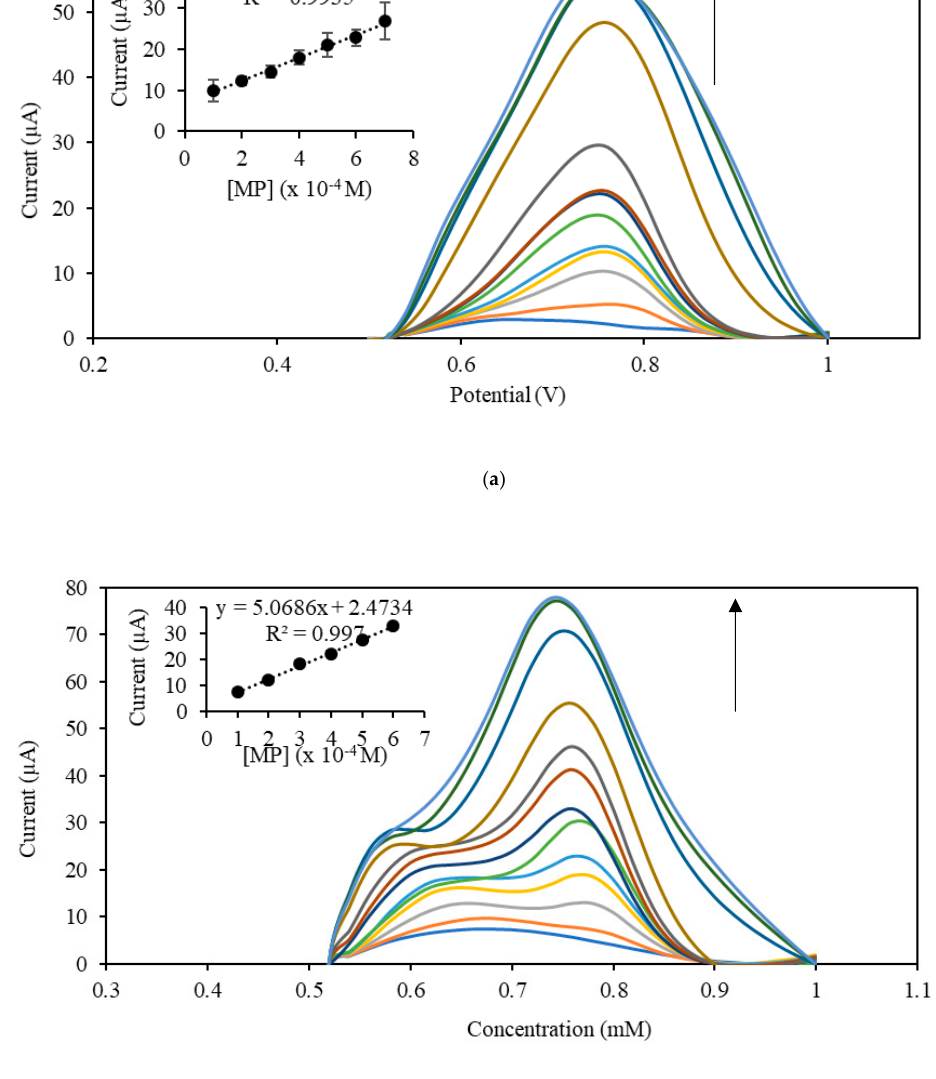
Figure 6. DPV voltammograms of ( a ) CNC – rGO nanocomposite and ( b ) rGO modified electrodes toward different concentrations of MP. The inset shows the linear calibration curve from 2 × 10 − 4 –9 × 10 − 4 M MP at 0.75 V (0.05 M PBS pH 7.0).